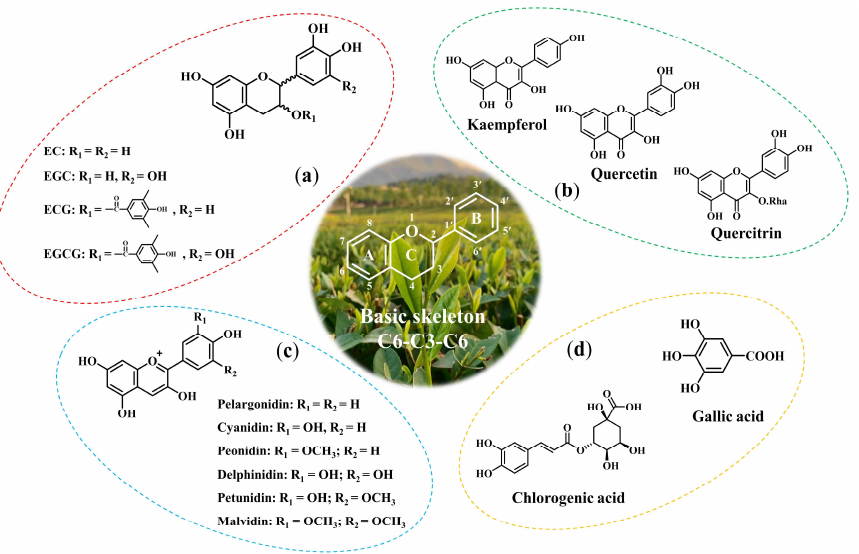
Figure 2. Structures of main polyphenols in tea. ( a ) catechins, ( b ) flavonoids and flavonols, ( c ) an- thocyanins, and ( d ) phenolic acids. ( c ) anthocyanins, and ( d ) phenolic